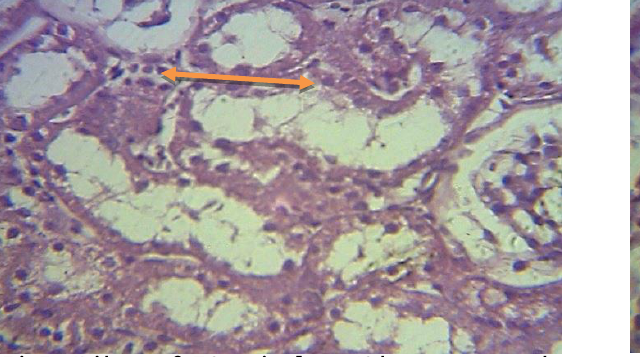
Fig. 8: Kidney of animal in T2 group 42 day post treated shows atrophy of glomerular tuft with thickness of boman capsule and desquamation of epithelial cells degeneration of epithelial lining cells of renal tubules (H and E stain 40x).